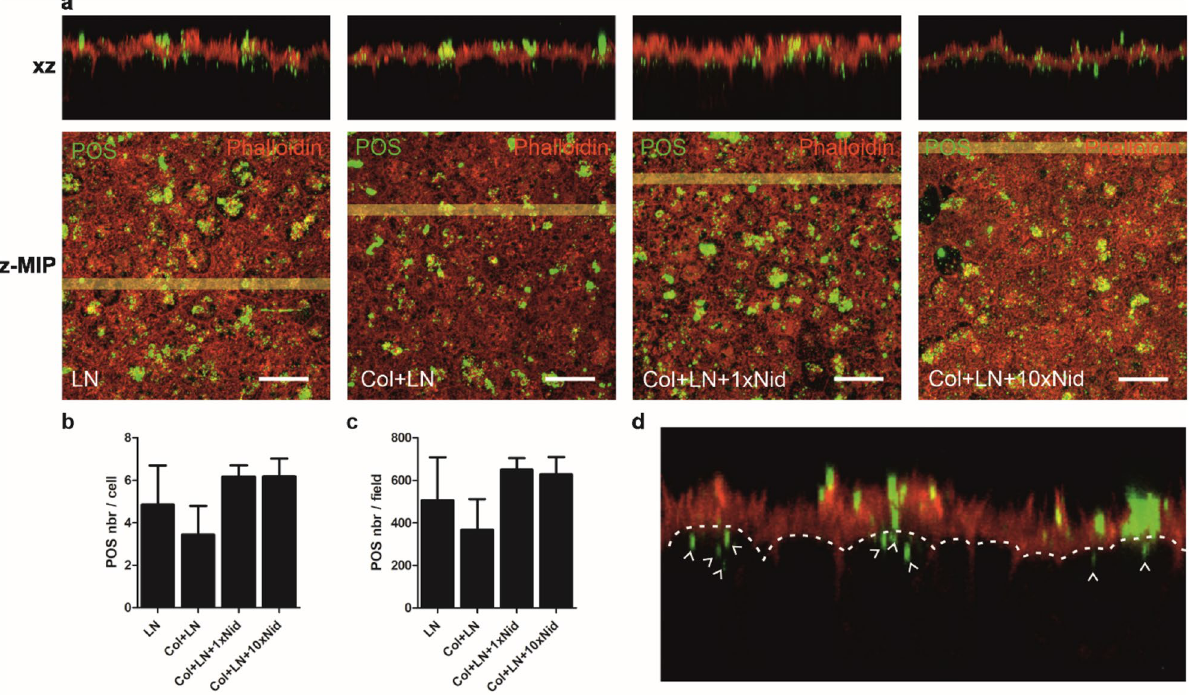
Figure 3. POS phagocytosis assay performed on hESC-RPE 13 weeks post-seeding with purified porcine POS (hESC-08/017, Table 1). ( a ) Representative laser scanning confocal microscopy z-maximum intensity y projections (z-MIP) and xz cross-sections (MIP from 20 sections) after 2-h phagocytic challenge showing the overall number, distribution and internalisation of the POS particles. The POS particles were labelled with anti- opsin (green) and filamentous actin with phalloidin (red). Scale bar 20 μm. Quantification of internalised POS particles ( b ) per cell and ( c ) per field. Each field contains cs. 100 cells. Internalised POS particles were manually calculated from each xz-MIP image (from five z-MIP images/coating). Both data represent means ± SD. The number of POS particles per cell between LN + Col and LN + Col + 1xNid (p = 0.0079) and LN + Col + 10xNid (p = 0.0079) was statistically significant. Similarly, POS number per field on Col + LN was statistically significant compared to LN + Col + 1xNid (p = 0.0079) and LN + Col + 10xNid (p = 0.0159). Statistical analysis was performed with Mann–Whitney U test. (d) A schematic image to demonstrate which POS particles (green) were calculated as internalised POS particles (white arrows). Col—collagen IV, LN—laminin,